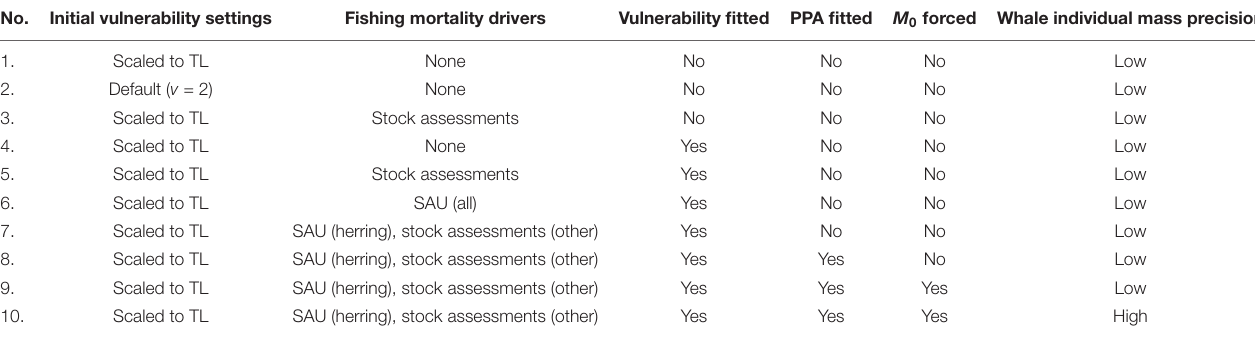
TABLE 2 | Fitting scenarios tested for the 1950 model. No. Initial vulnerability settings Fishing mortality